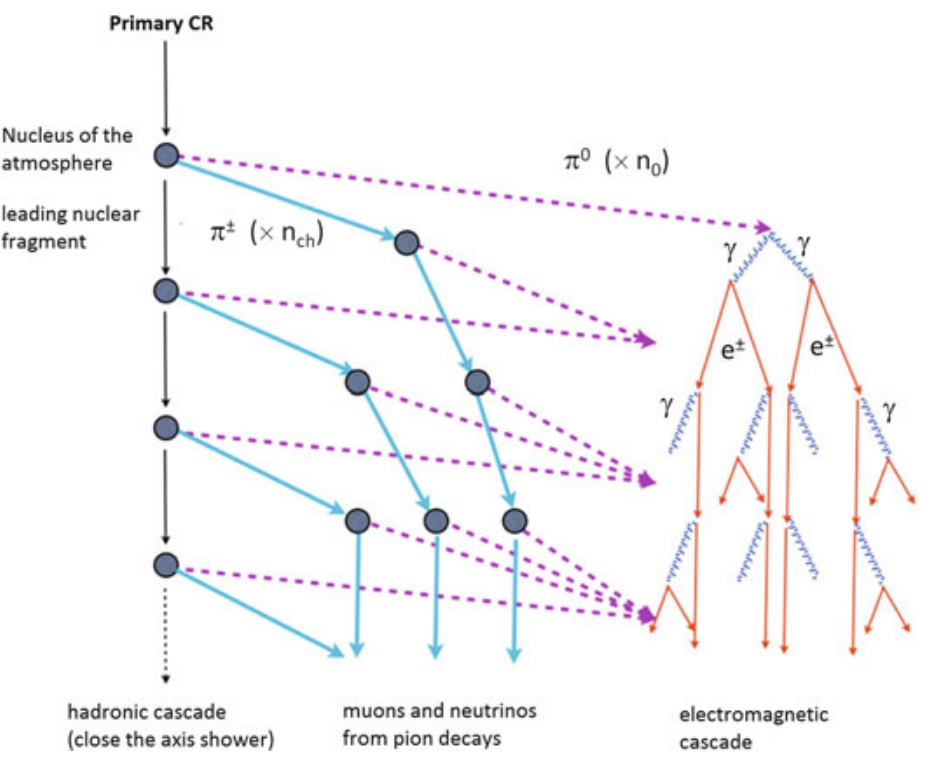
Figure 3. Schematic evolution of cascades initiated by a CR particle. At each step, roughly 1/3 of the Fig. 4.4 Schematic evolution of cascades initiated by hadrons. At each step, roughly 1/3 of the energy is transferred from the hadronic cascade to the e.m. one. Figure taken from energy is transferred from the hadronic cascade to the electromagnetic one (Letessier-Selvon and Stanev 2011)